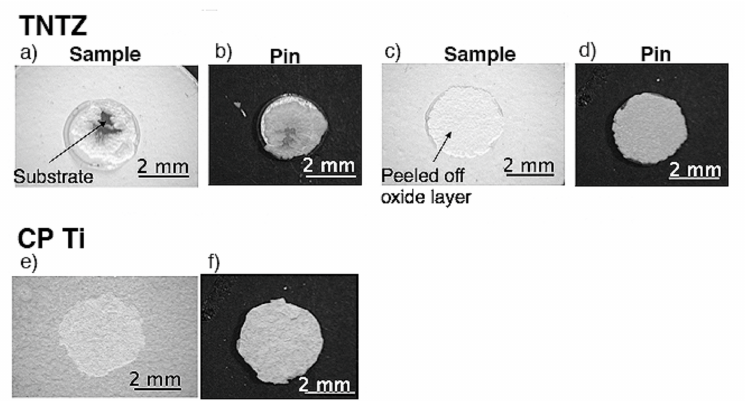
Figure 3. Exfoliated surface of specimens after exfoliation tests at each time duration in Ti–36Nb– 2Ta–3Zr–0.3O. ( a – d ) Tested specimens after oxidization with different time durations (0.9–3.6 ks) at 1273 K; ( e ) enlarged image of a typical exfoliated surface.